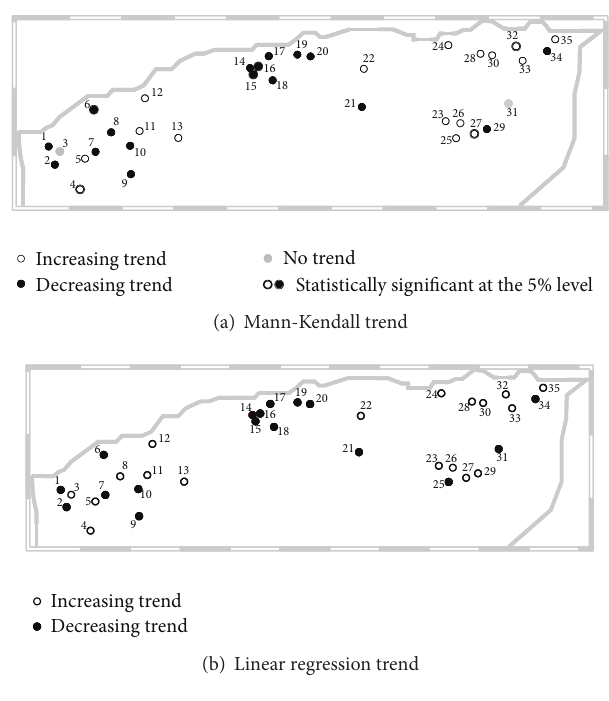
Figure 5: Mann-Kendall (a) and linear regression (b) trend of AMDR over the period after 1970 in northern